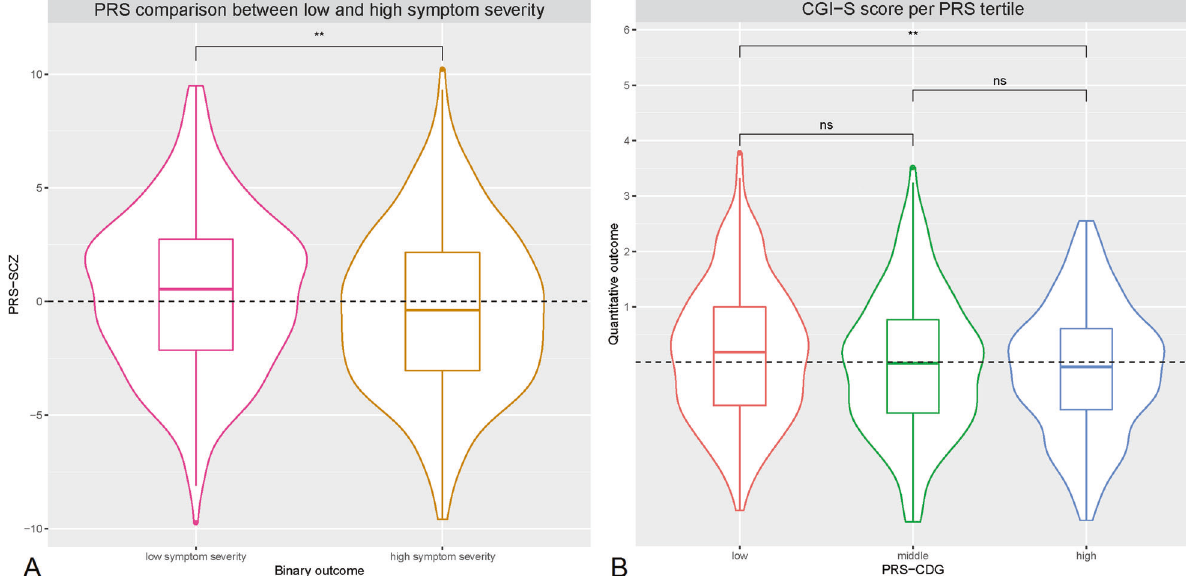
Fig. 3 Violin plots displaying the distribution in symptom severity while on clozapine by polygenic risk score subgroups. A, B Violin plots of schizophrenia-PRS (PRS-SCZ) comparison for binary outcome, and cross-disorder-PRS (PRS-CDG) tertile comparison for quantitative outcome. For both analyses the best fi tting p was used. The dashed line illustrates the mean PRS-SCZ ( A ) and the mean residual CGI-S score ( B ) in all participants. Differences were determined by linear regression of quantitative outcome on PRS tertile and using a T -test for binary outcome, corrected for sex, age, and 10 PCs (Supplementary Methods). ** p < 5.0 × 10 − 3 . ns nonsigni fi cant.